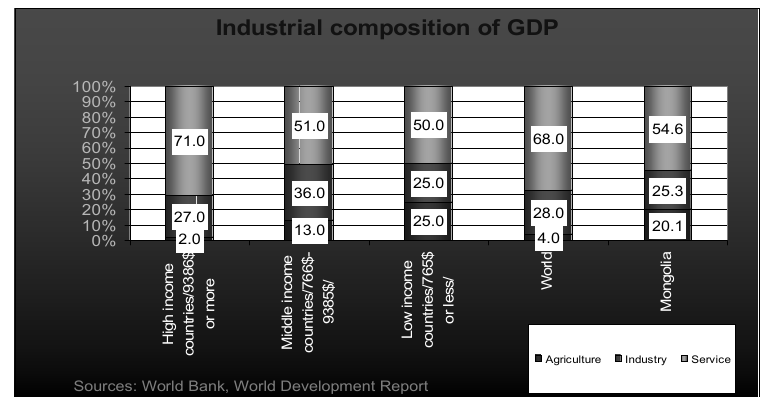
Fig. 6 – Industrial composition of